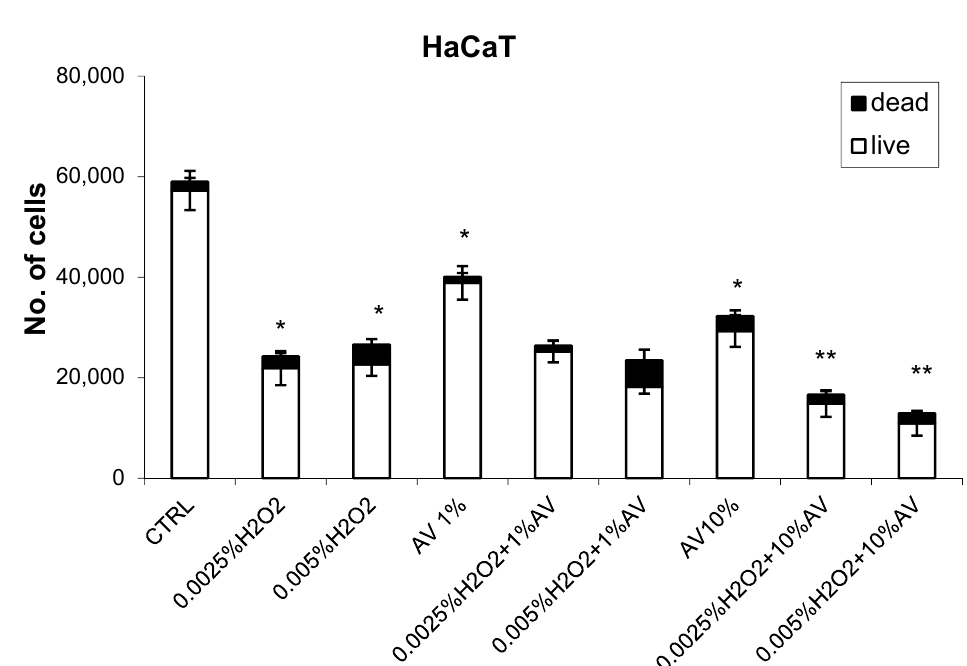
Figure 4. The effects of AV extract (1 or 10%) on the human keratinocyte (HaCaT) cells with respect to H 2 O 2 treatment (0.0025% or 0.05%). The cell count values (viability determined using Trypan blue) were obtained 24 h after treatment (H 2 O 2 followed by AV extract 1 h later) and are given as mean values for triplicates. * significant difference to untreated control; ** significant difference to respective H 2 O 2 treatment alone.